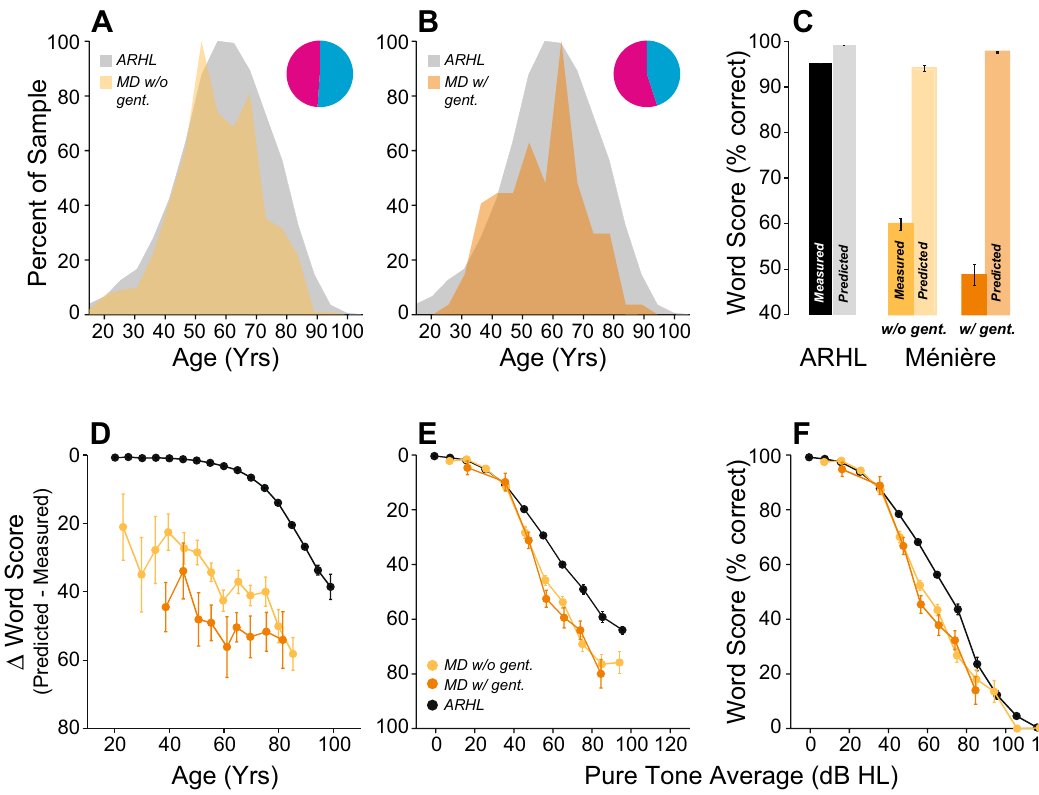
Figure 10. Intelligibility deficits in patients diagnosed with Ménière’s disease are dramatically worse than age- matched controls. ( A , B ) Age distribution of patients with Ménière’s disease who received (MD w/ gent., ( B ) or not (MD w/o gent., ( A ) a trans-tympanic injection of gentamicin as part of their treatment. Pie charts indicate the proportion of male (cyan) vs. female (magenta) for each group. ( B ) Comparison of mean WRS as measured in patients with Ménière’s disease or predicted by the speech intelligibility curve. Scores were compared with patients presenting ARHL. ( D – F ) Speech Intelligibility deficits as a function of age ( D ) or pure-tone average ( E , F ). Legend in ( E ) applies to ( D , F